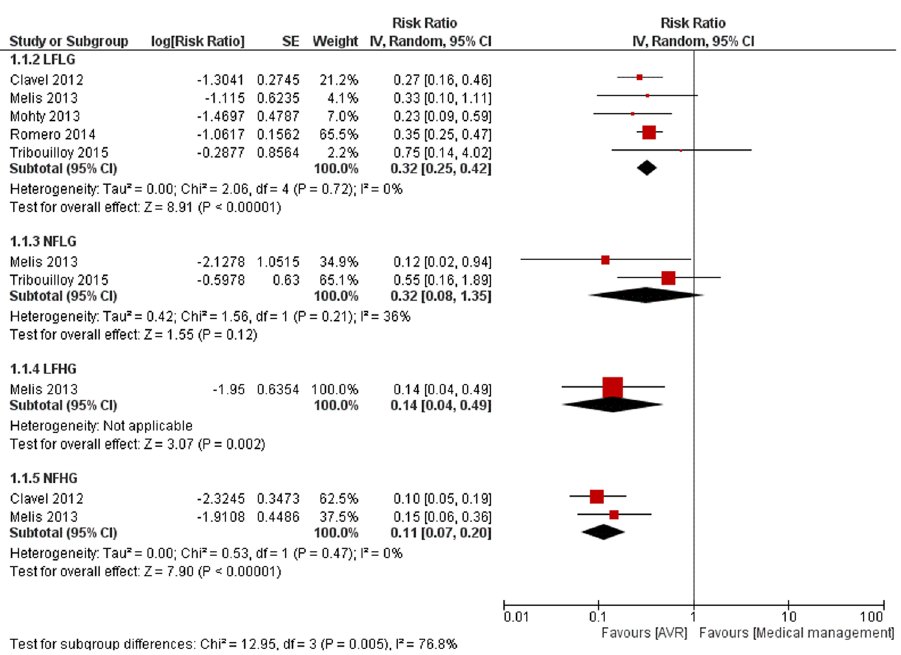
Figure 6. Direct comparisons of the effects of AVR versus medical therapy on the different flow-gradient